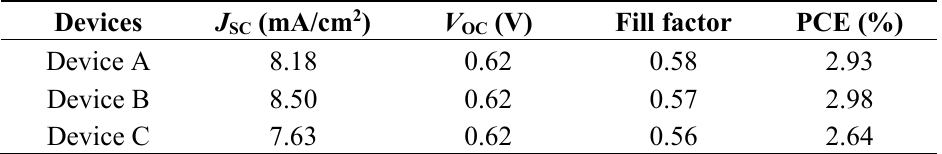
Table 1. The steady-state characteristics of